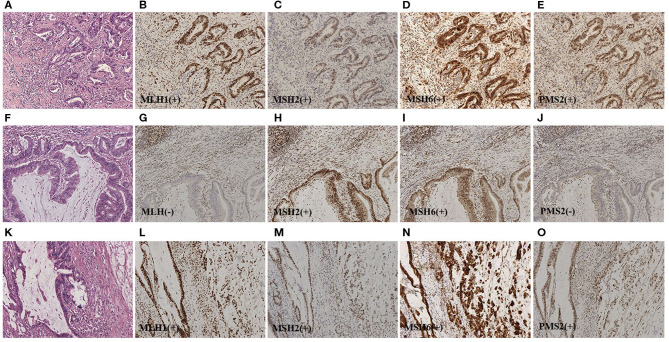
(A) Representative HE staining of classical adenocarcinoma (HEx100). For (B–E), representative IHC staining for the four MMR proteins of serial sections from pMMR classical adenocarcinoma (IHCx100). Stromal cells and infiltrating lymphocytes served as internal positive controls. (F) Representative HE staining of dMMR AWMC (HEx100). For (G–J), representative IHC staining for the four MMR proteins of serial sections from dMMR AWMC (IHCx100). Stromal cells and infiltrating lymphocytes served as internal positive controls. In this case, MLH1 and PMS2 were negative. (K) Representative HE staining of AWMC with signet ring cell component (HEx100). For (L–O), representative IHC staining for the four MMR proteins of serial sections from pMMR AWMC with signet ring cell component (IHCx100). Stromal cells and infiltrating lymphocytes served as internal positive controls.